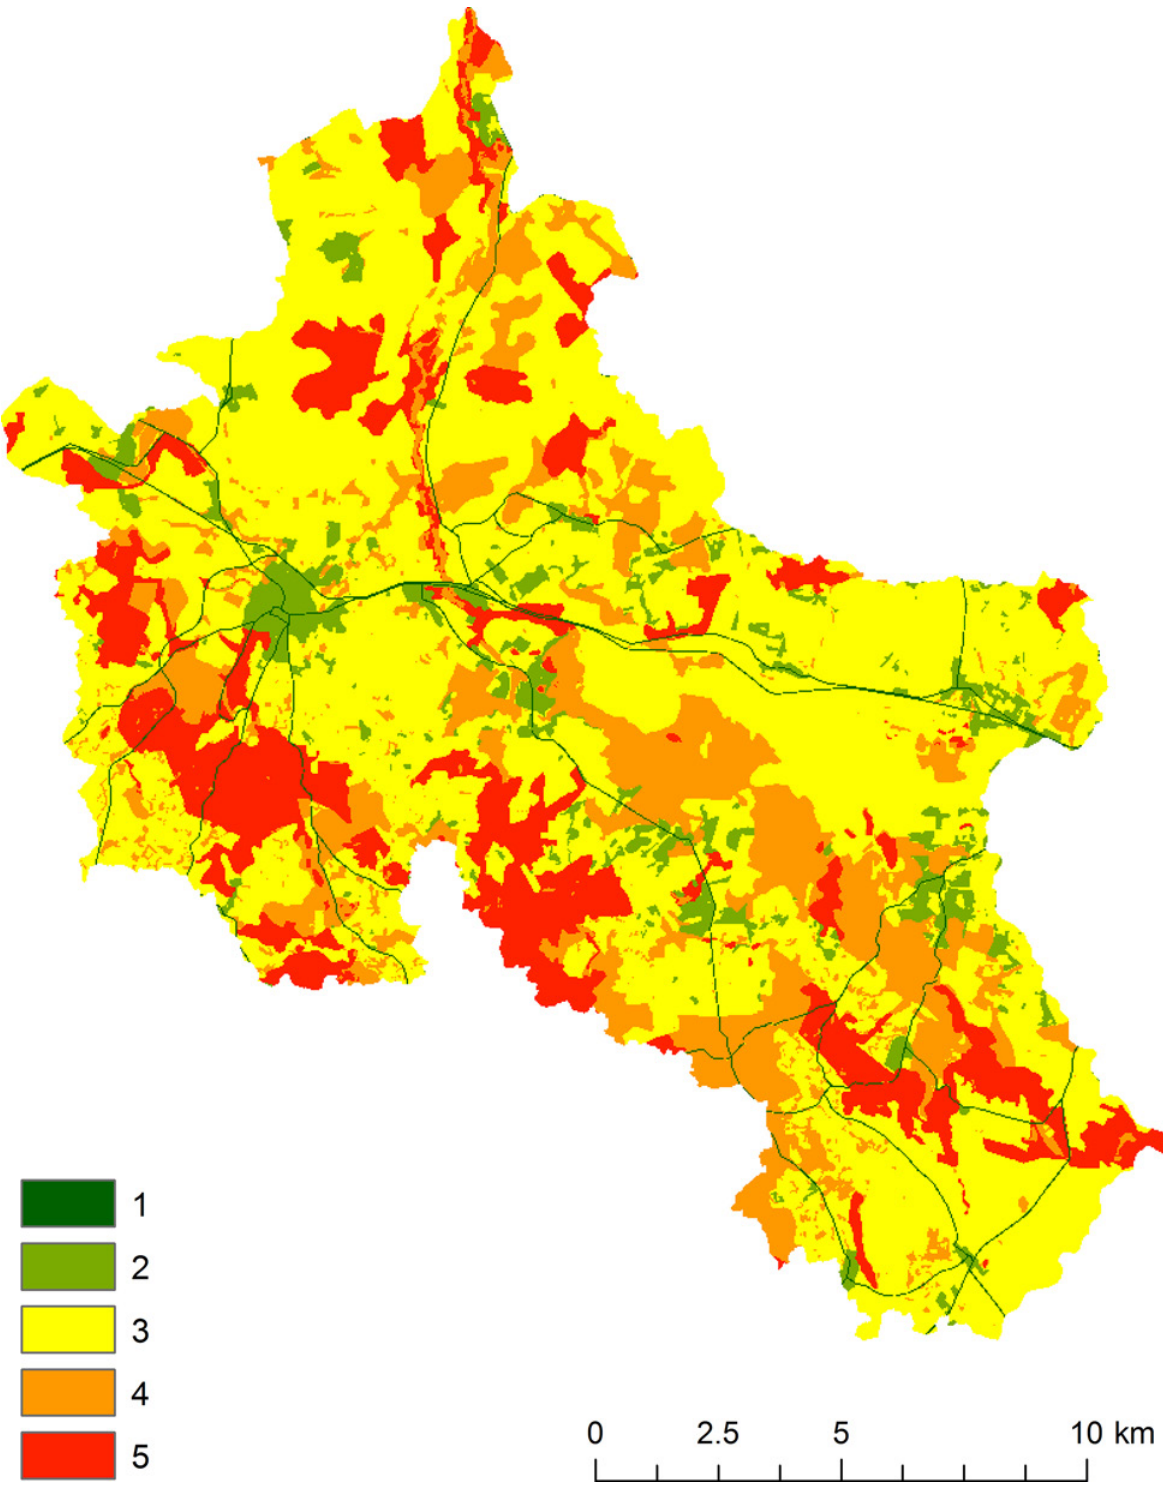
Fig. 11. total biodiversity map of dębnica river